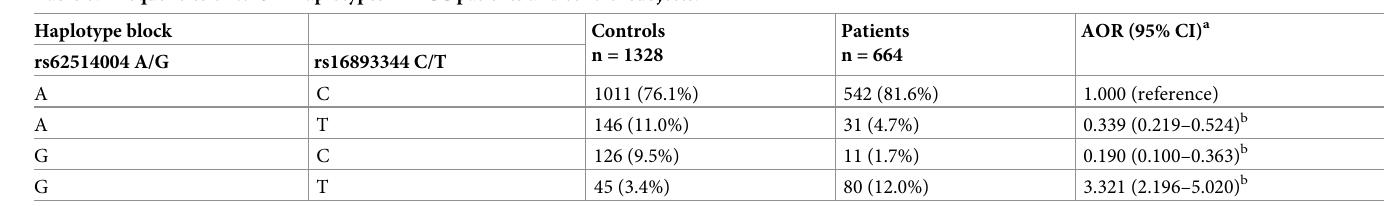
Table 6. Frequencies of WISP1 haplotypes in HCC patients and control